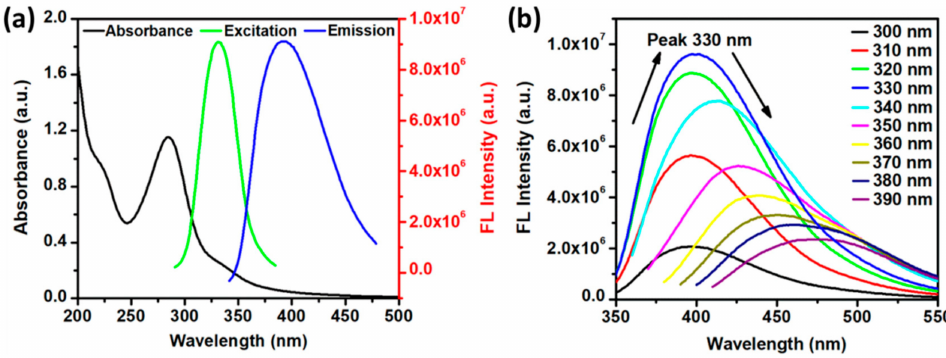
Figure 4. ( a ) UV-vis absorption spectra ( black line ), and fluorescence excitation ( λ ex = 330 nm, green line ) and emission ( λ em = 410 nm, blue line ) spectra of N-CQDs. ( b ) Fluorescence emission spectra of N-CQDs obtained under di ff erent excitation wavelengths (from 300 to 390 nm with 10 nm